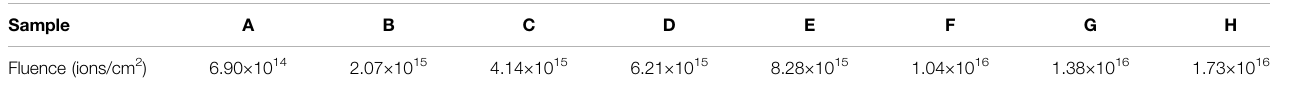
TABLE 1 | Nominal implantation fl uence for different samples.